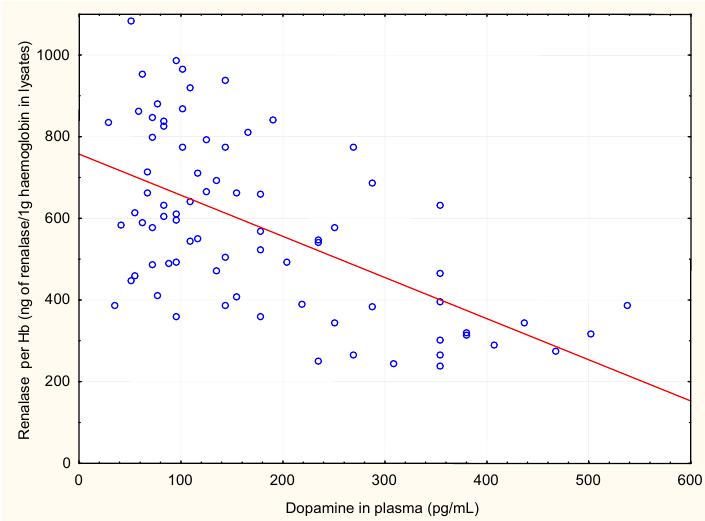
Figure 2. Correlation between concentrations of renalase per Hb (ng of renalase/1 g haemoglobin in lysates) and dopamine in plasma of hemodialysis